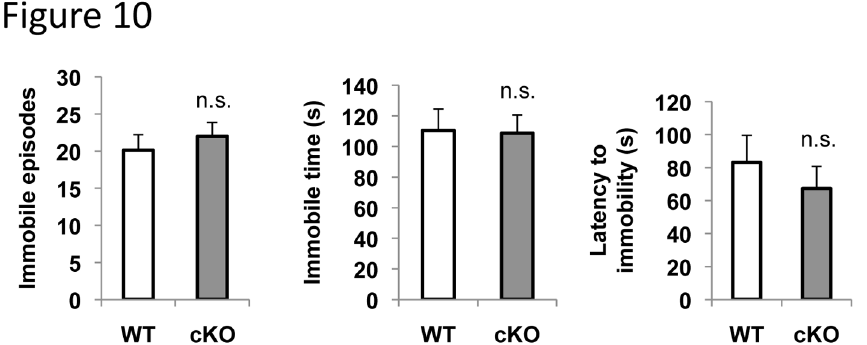
Figure 10. ERK5 deletion does not cause depression in a forced swim test. Mice were subjected to a 6-min session of a forced swim test; the duration of total immobile time and total immobile episodes during the 2-6 min timeframe of the session, as well as the latency to first immobile episode were scored. n.s., not significant.